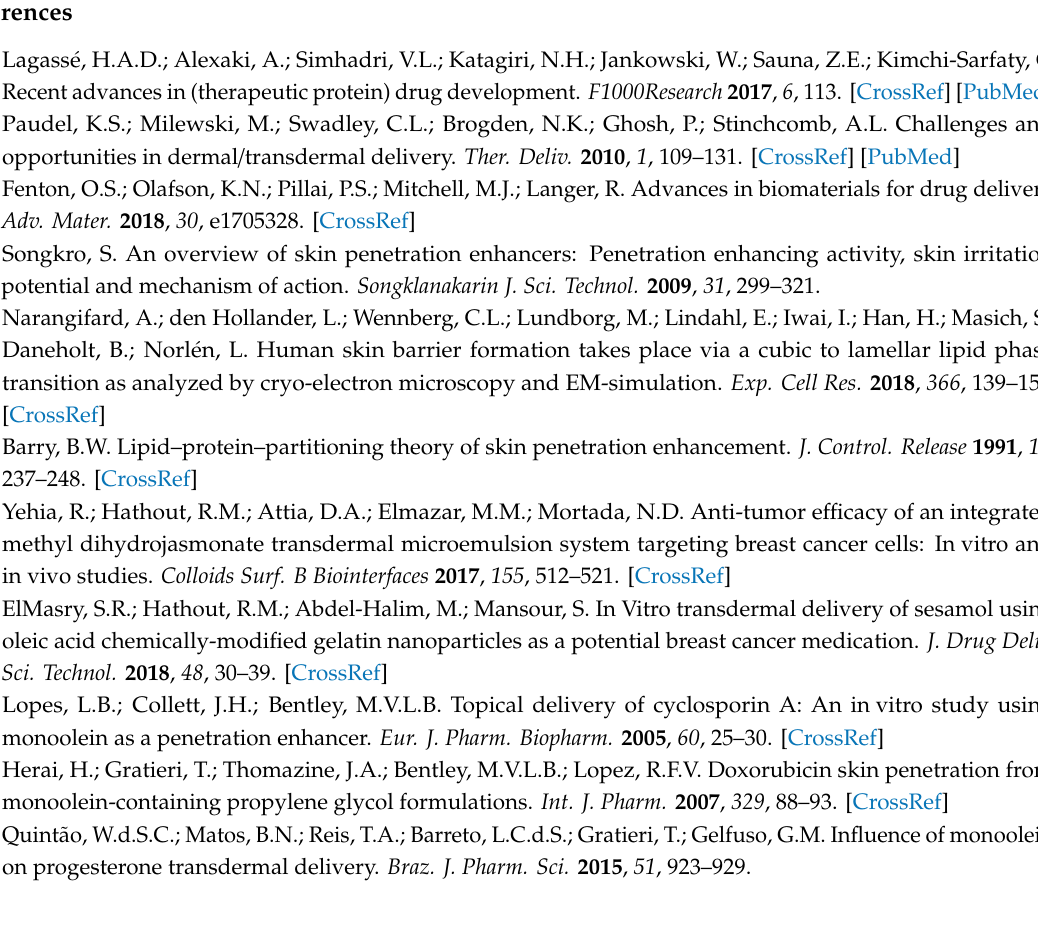
Figure S1: Physical properties of proteins examined in the skin permeability test and the amounts that permeated Yucatan micropig skin using oil-dispersion systems and PBS solutions (1 mg / mL,